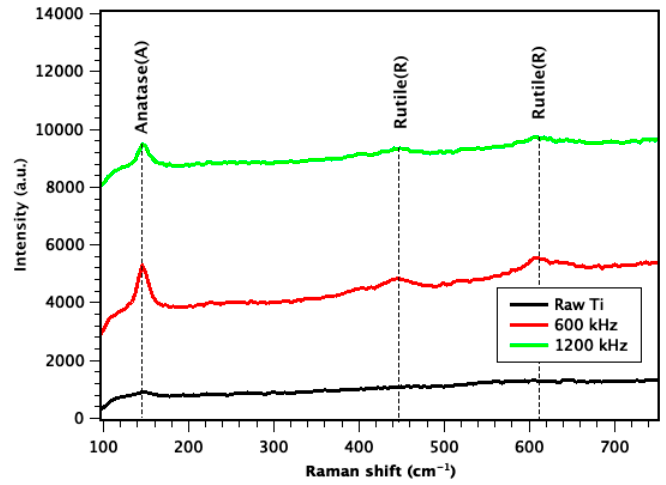
Figure 2. Micro-Raman results of S1, S2, and Figure 2. micro-Raman results of S1, S2, and S3.